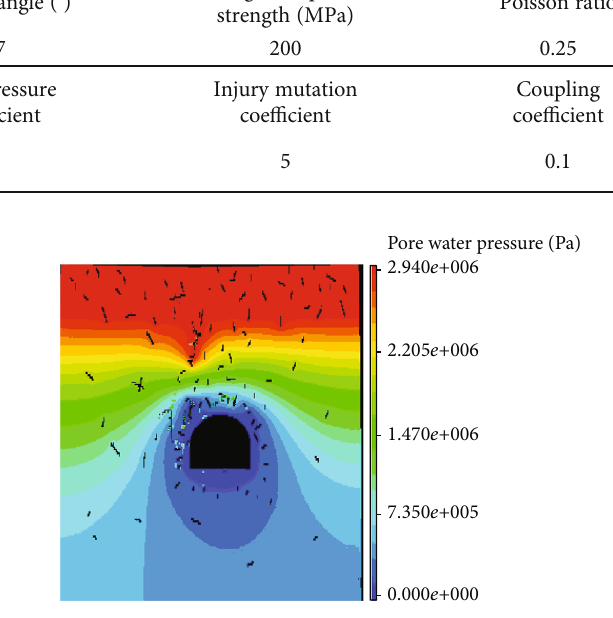
Figure 7: Distribution of the seepage fi eld in the surrounding rock of the seepage